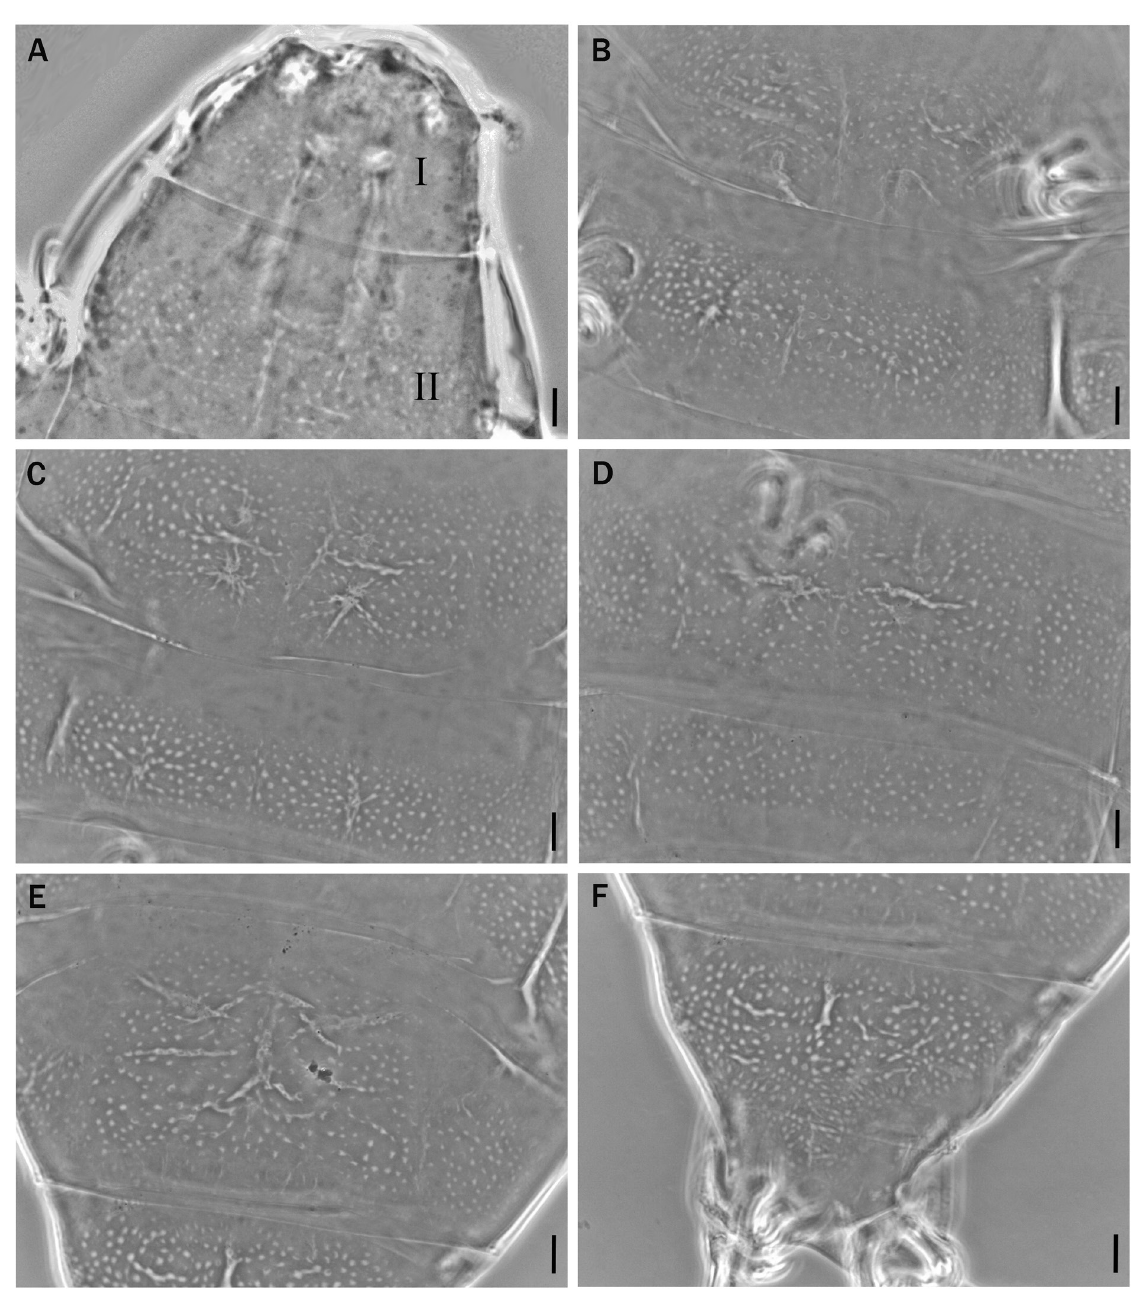
Fig. 11. Milnesium pelufforum sp. nov., holotype, ♀ (slide No. MCNS tar. 000021-3). Overview of the ten bands of cuticular dimples from the head (above) to the caudal end of the body (below) A . First and second bands (roman numbers). B . Third and fourth bands (the fourth also shows in the centre several dimples with internal structures). C . Fifth and sixth bands. D . Seventh and eighth bands (the seventh also shows in the centre some dimples with internal structures). E . Ninth band. F . Tenth band. In all pictures (A–F) cuticular grooves are also visible. Scale bars = 10